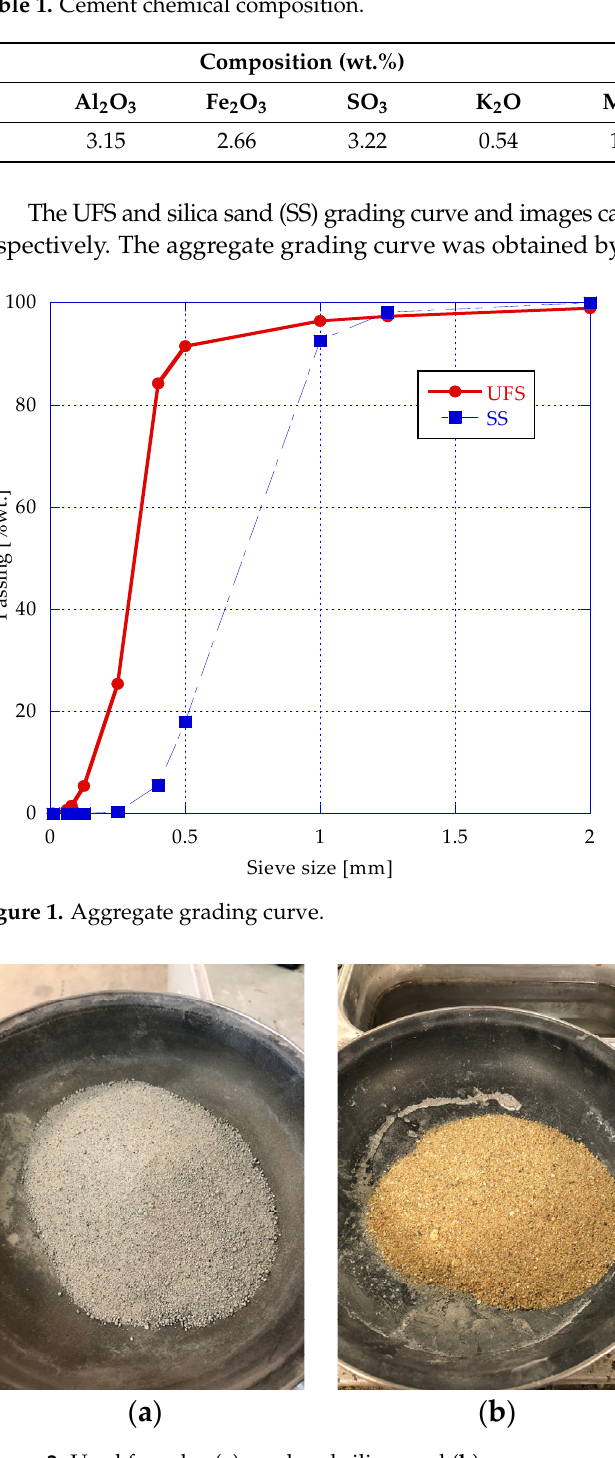
Figure 2. Used foundry ( a ) sand and silica sand ( b ).